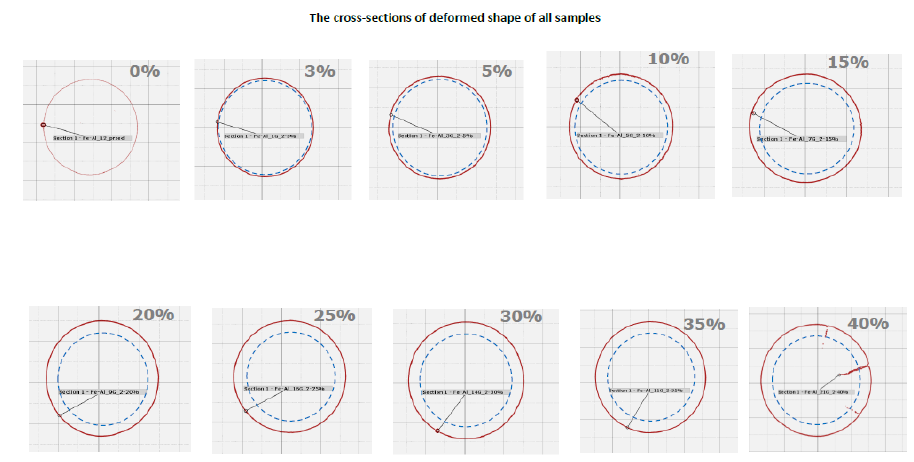
Figure A1. Typical course of temperature and shrinkage during sintering by the PAIS method — specimen 1.